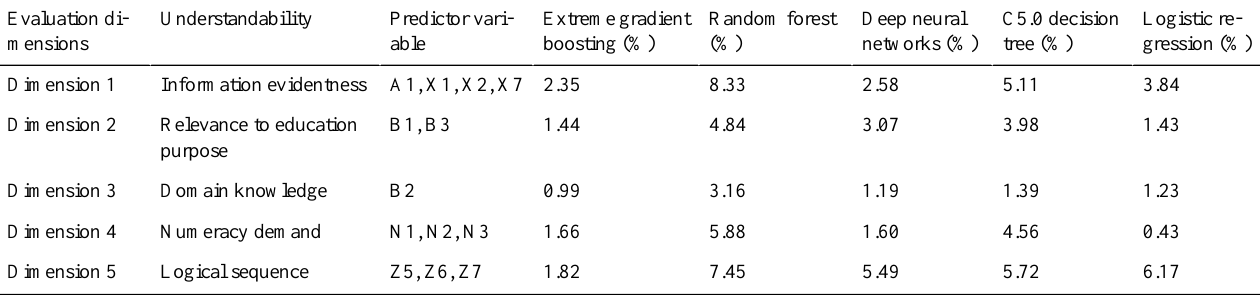
Table 7. Impact of the different dimensions on the area under the curves of the